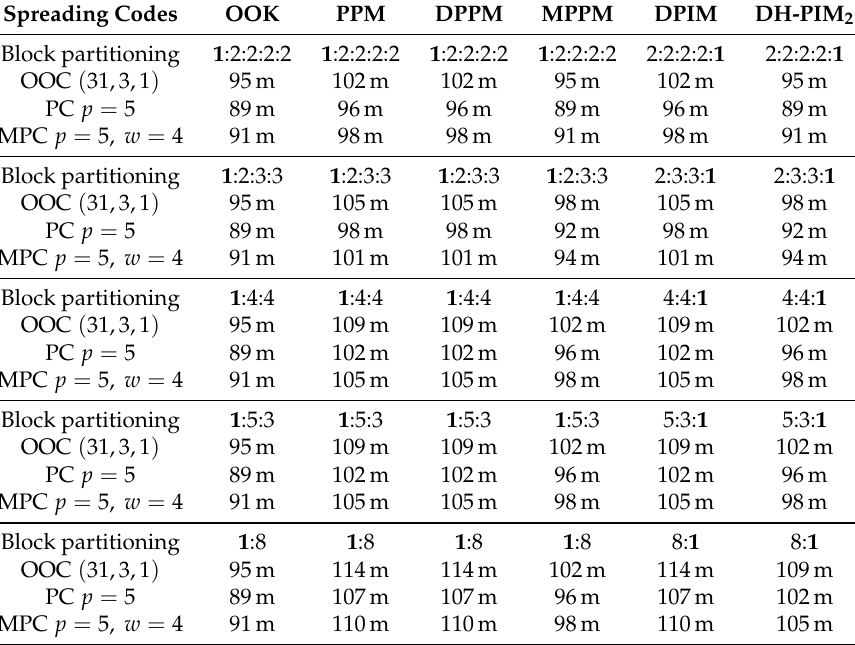
Table 14. Maximum distance R max as a combination of modulation and spreading code. Spreading